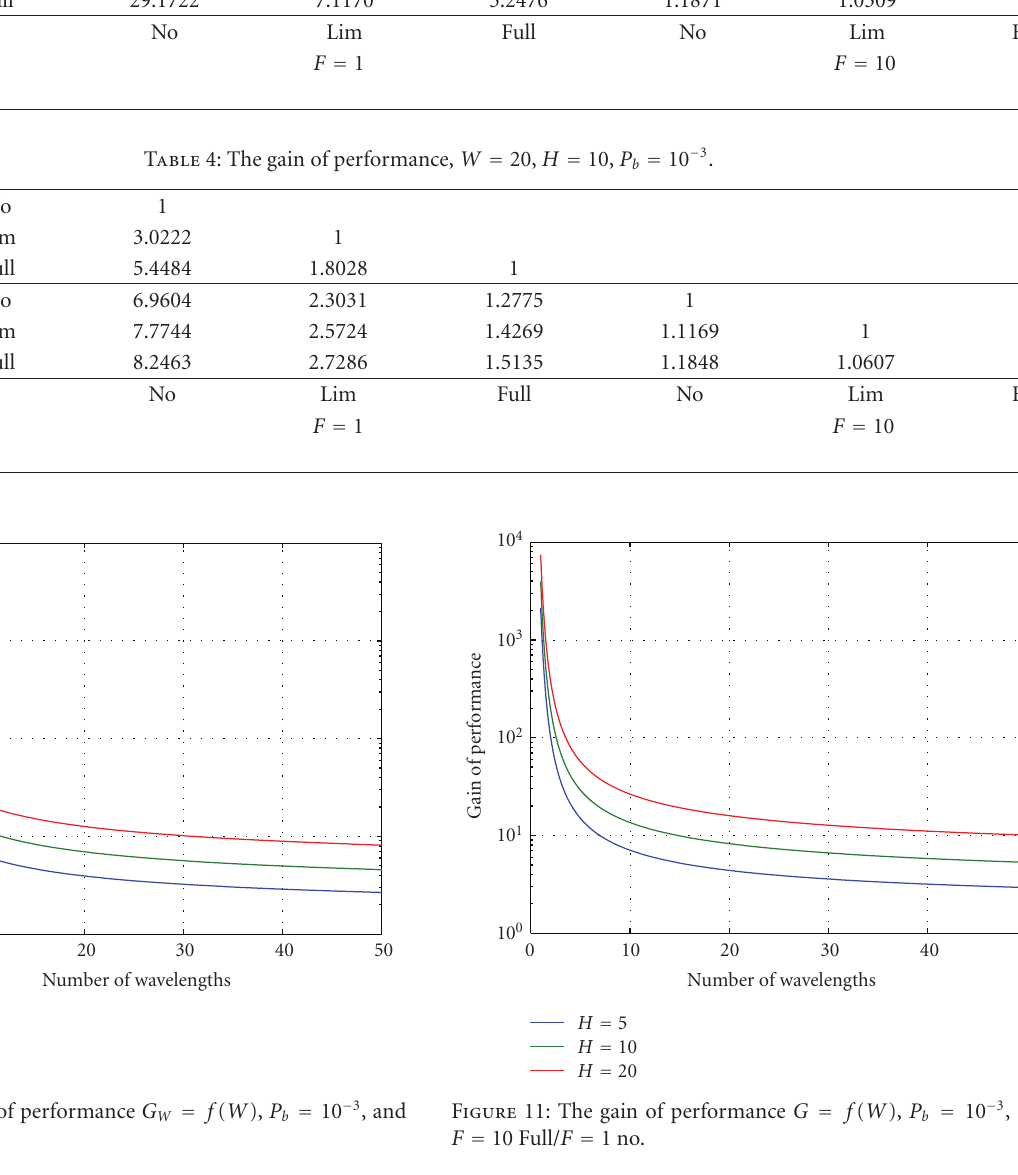
read. The numerical results of all possibilities are summa- Table 4 for W = 20, H = 10, and P b = 10 − 3